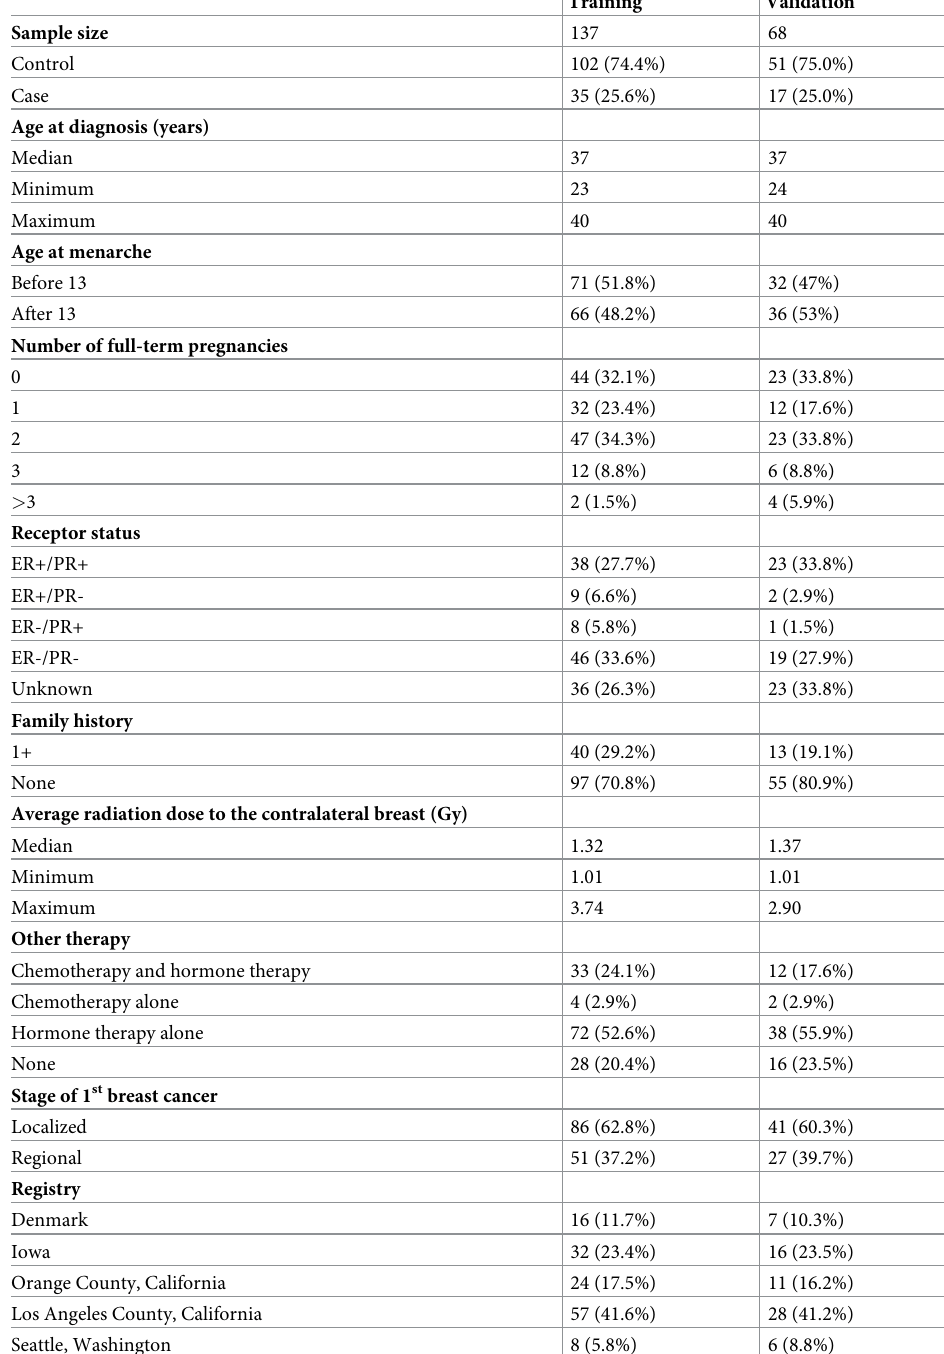
Table 1. Patient characteristics of training and validation